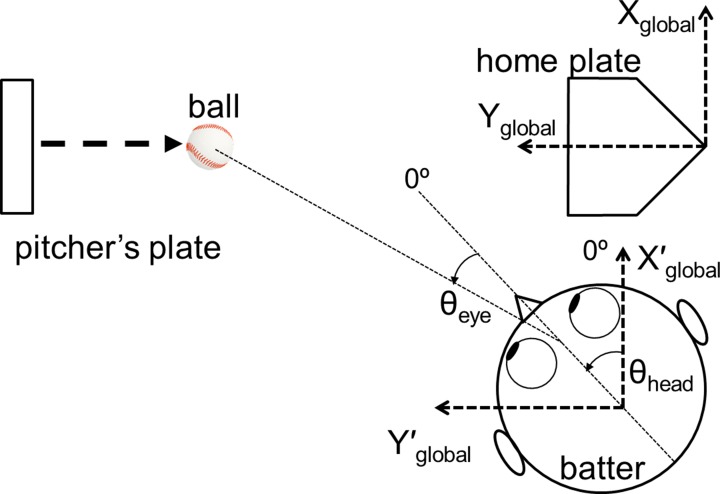
Eye (θeye) and head angles (θhead) on the global XY plane when the batters observed a moving baseball.